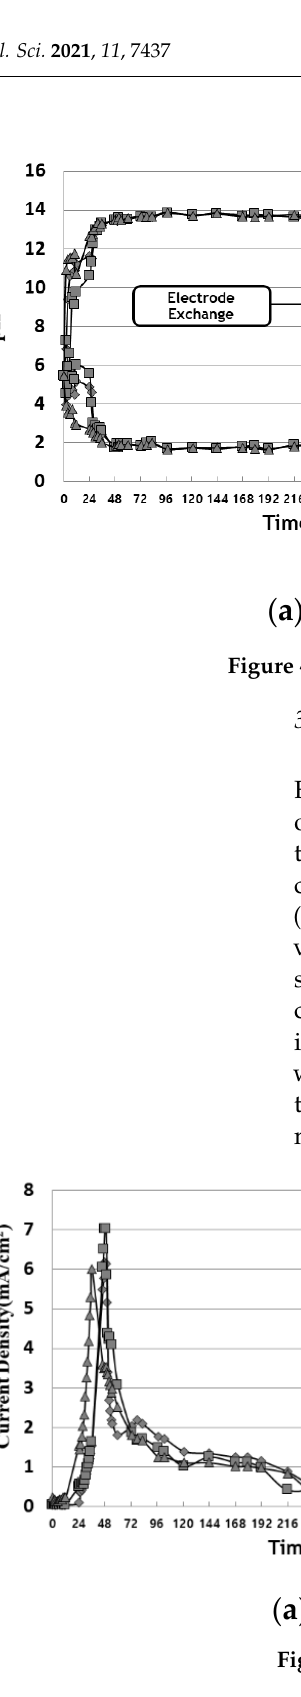
Figure 5. Current density during EK experiment: ( a ) copper; ( b ) lead.